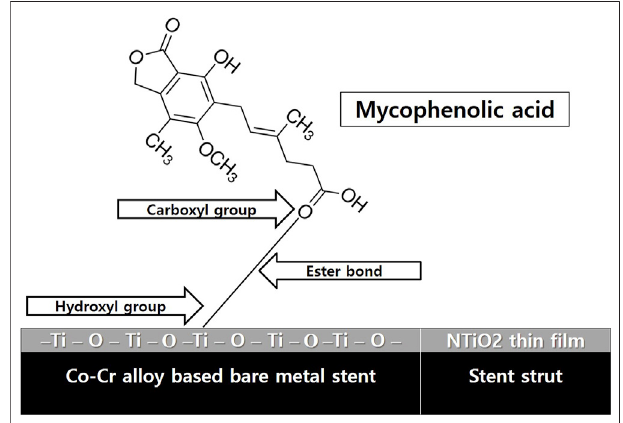
FIGURE 1 | Schematic illustration of NTM. NTM, TiO 2 fi lm – coated stent with mycophenolic